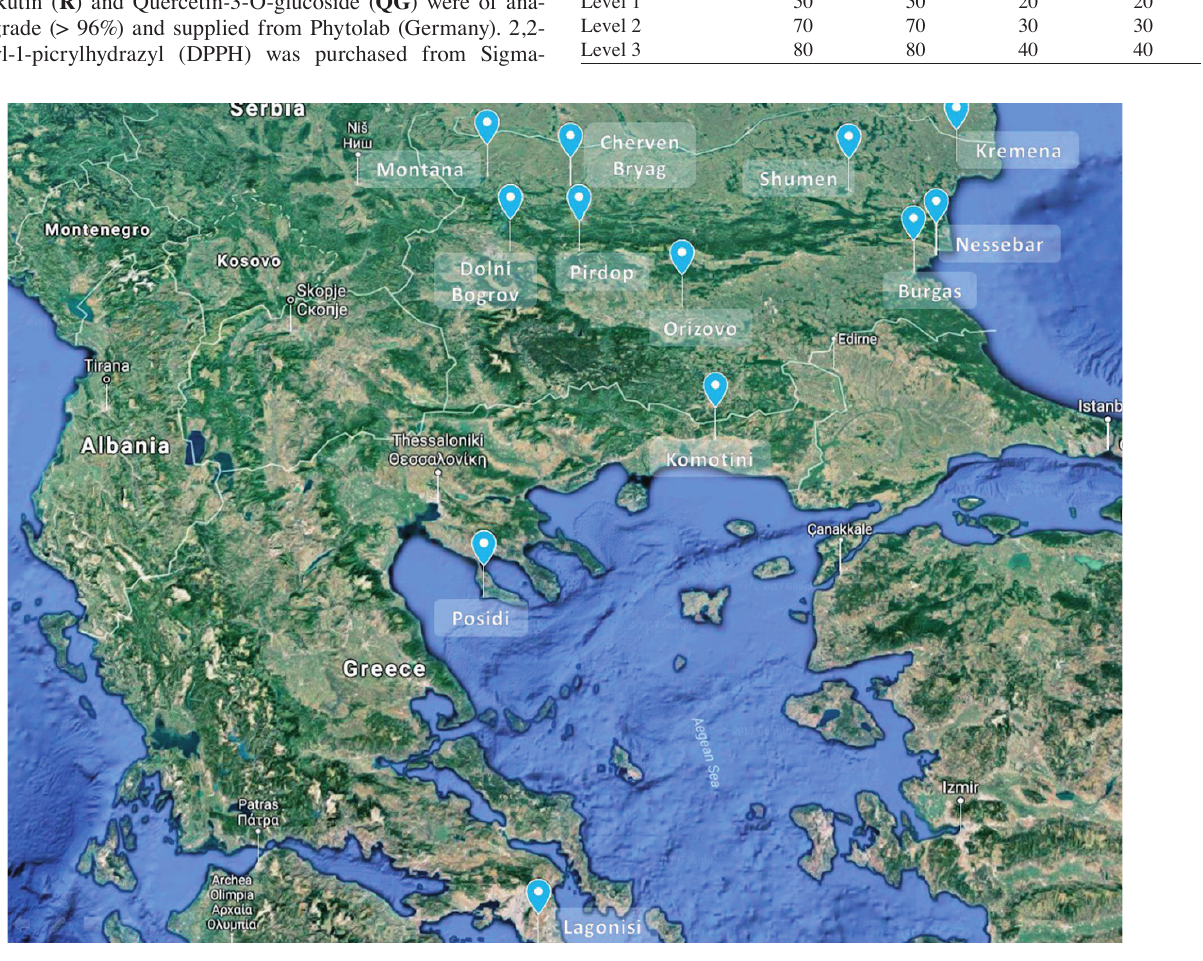
Fig. 1: Locations in Bulgaria and Greece where aerial parts of Portulaca oleracea L were collected.